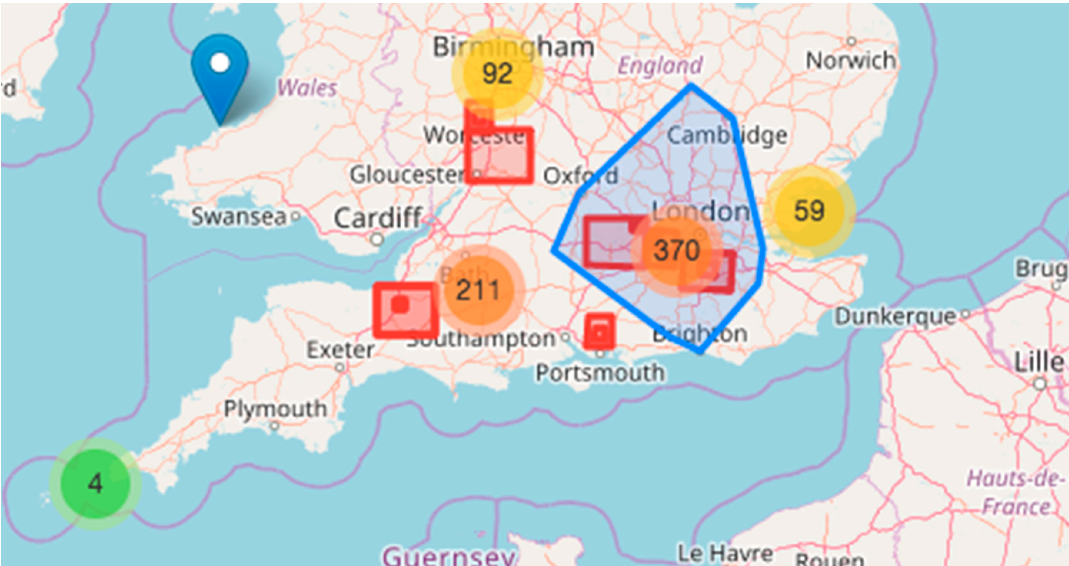
Figure 1. Social crisis map for 2014 Southern England floods–the areas in red refer to maps produced in the EMSR069 Copernicus rapid mapping activation; tweets are clustered based on their geographical location which is visualised as the absolute number of tweets containing an image. The clusters, represented as orange/yellow/green circles point out the size of the cluster from largest to smallest; by clicking on a number, all underlying tweets are displayed together with an outline of the area in blue.